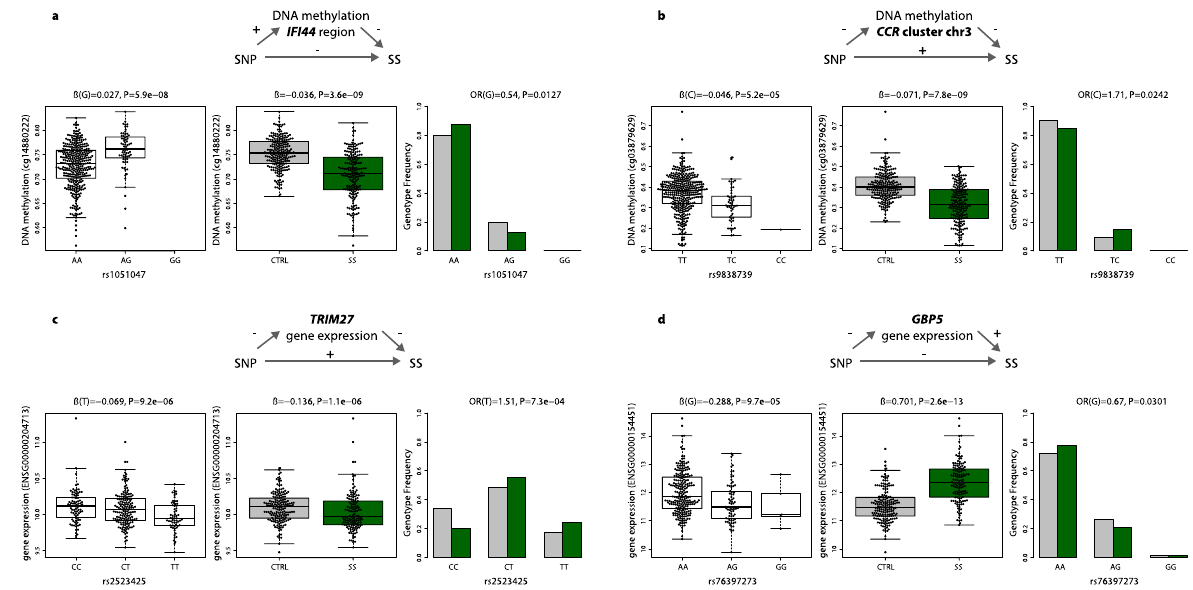
Figure 4. Intermediary role of DNA methylation and gene expression in SS genetic risk. ( a ) The minor G-allele of SNP rs1051047 exerts a protective role on SS susceptibility by increasing DNA methylation levels at the upstream region of gene IFI44 (cg1488022). ( b ) The minor C-allele of SNP rs9838739 exerts risk on SS susceptibility by decreasing DNA methylation levels at the intergenic region within the CCR cluster in chromosome 3 (cg03879629). ( c ) The minor T-allele of SNP rs2523425 exerts risk on SS by decreasing TRIM27 gene expression. ( d ) The minor G-allele of SNP rs76397273 exerts a protective effect on SS by decreasing GBP5 gene expression. Green boxplots and barplots represent SS population, while grey plots represent the healthy control population. DNA methylation is quantified with β-values, gene expression is at the logarithmic scale. R software 73 and Adobe Illustrator (https:// www. adobe. com/) was used to create interact with disease status on shaping DNA methylation and gene expression levels at SS-associated DMPs and DEGs. We considered relevant and robust disease interacting QTLs those that accomplish the following strict conditions: i) an interaction effect that passes a significance threshold of P INTER < 0.005 in the discovery cohort and a significance threshold of P INTER < 0.05 in the replication cohort, with consistent direction of the effect, ii) genetic variant associated with DNA methylation or gene expression only in the SS group (P SS.QTL < 0.05) and without evidence of genetic associations in the healthy population (P CTRL.QTL > 0.05), iii) genetic variants that show a minor allele frequency higher than 0.10 in the SS group. For DNA methylation, we observed convincing evidence for disease-interacting meQTLs at 8 SS-associated DMPs within genes TAP1, LY6E, PSMB8, STAT1, SGK269 and ATP10A (Table 3 and Supplementary Table 17). The most significant gene-environment interaction (ß INTER = -0.018, P INTER = 2.0 × 10 –04 ) that fell outside the HLA region involved the genetic variant rs13273708 at chromosome 8 and DNA methylation at LY6E (cg14392283) (Fig. 4a, Table 3) . For this variant, the minor C-allele is associated with a decrease in LY6E -DNA methylation only in SS patients, but this association is not observed in the healthy population (Table 4). A similar scenario is observed for the STAT1 gene for which we found the second most significant disease-dependent meQTLs effect (ß INTER = −0.029, P INTER = 5.47 × 10 –04 ) outside the HLA region (Fig. 5b). Another convincing example implicates the interaction between SS status and rs1079396 in shaping DNA methylation levels at SGK269 gene (ß INTER = −0.024, P INTER = 0.003, Fig. 5c), and the interaction with rs7169481 in shaping DNA methylation at ATP10A (cg10734665 , ß INTER = 0.022, P INTER = 0.003, Fig. 5d). For gene expression, some IFN-inducible genes such as MX2 , IFITM1, EPST1 , MX1 and LY6E-DT show convincing evidence that their expression is genetically